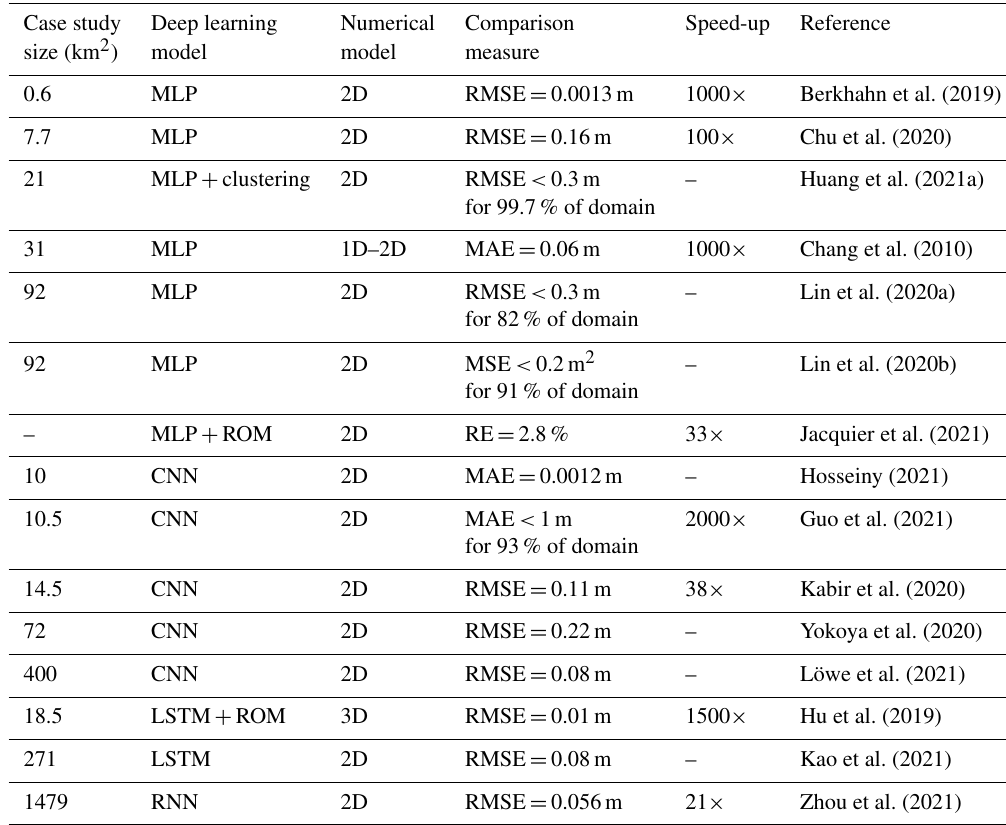
Table 5. Performance of the deep learning and comparison with numerical models for flood